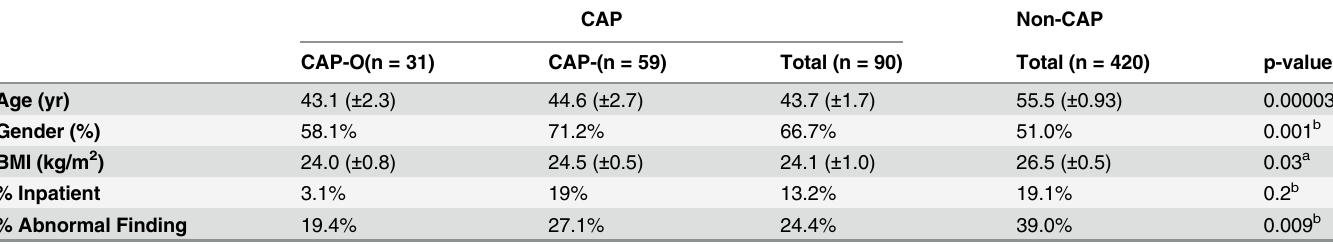
Table 1. Characteristics of patients with CAP and those receiving VCE for all other indications.